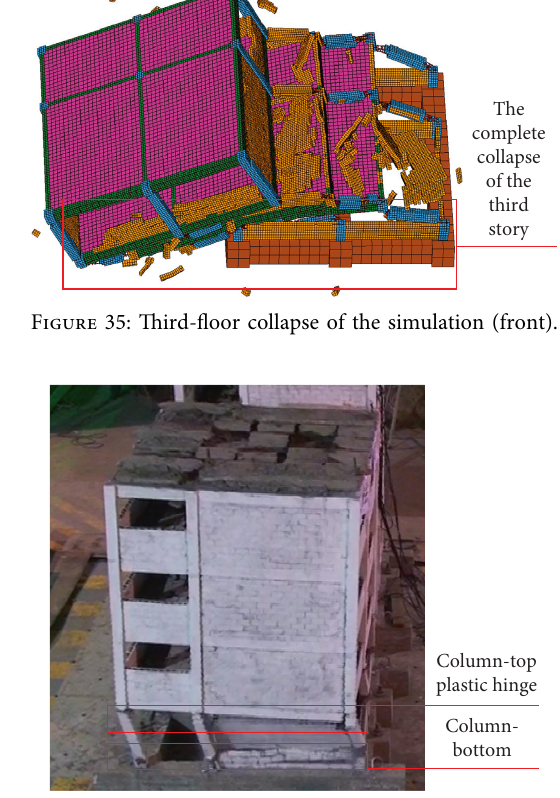
Figure 39: Frist-floor collapse of the simulation